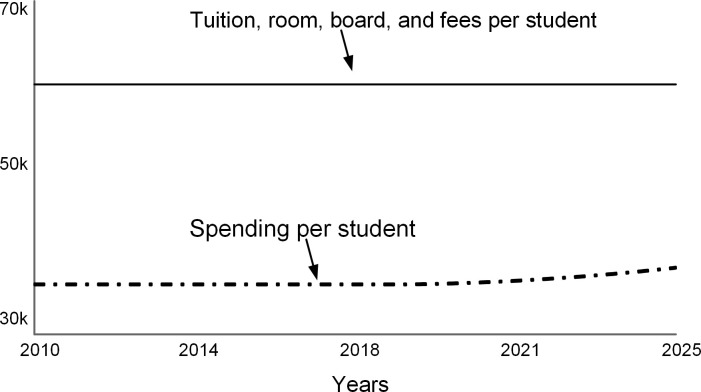
Metrics per student.